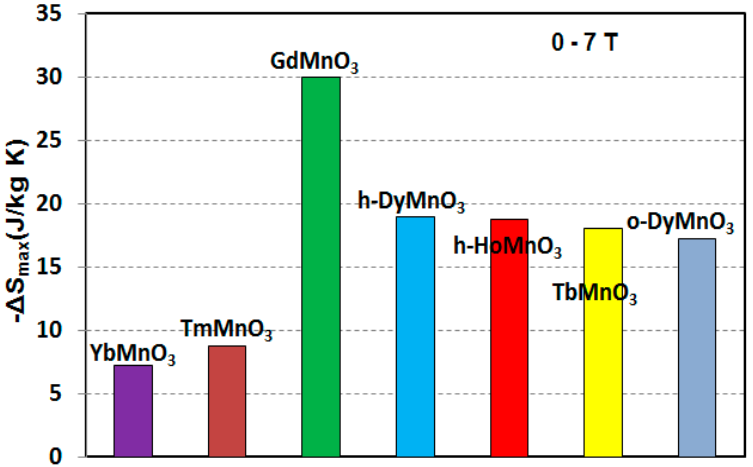
Figure 10. Maximum entropy change of RMnO 3 single crystals under a magnetic field of 7 T applied along their easy directions, with R = Yb [26], Tm [23], Gd [87], h-Dy [22], h-Ho [27], Tb [21], and o-Dy [24].